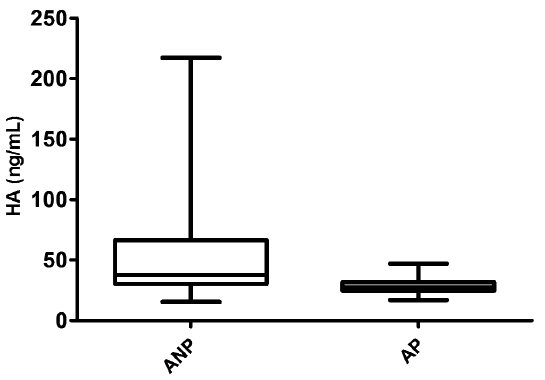
Figure 1. Circulating HA levels measured in asthmatic preg- nant and non-pregnant women*. HA – hyaluronic acid; ANP – asthmatic non-pregnant; AP – asthmatic pregnant; p=0.006; *data not adjusted for age.